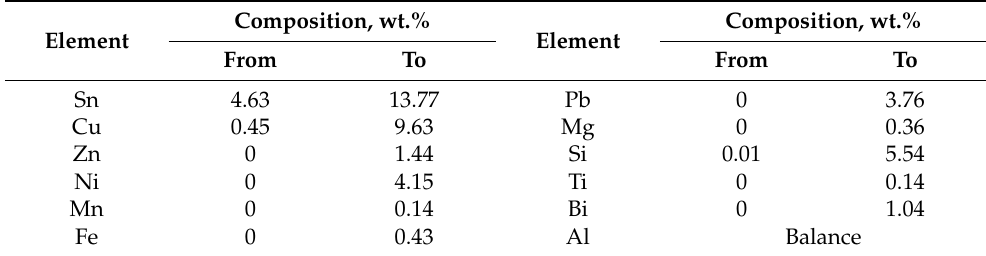
Table 1. The chemical composition of the added alloying elements to Al-based anti-friction alloys. Composition, wt.% Composition, wt.% Element Element From To From To